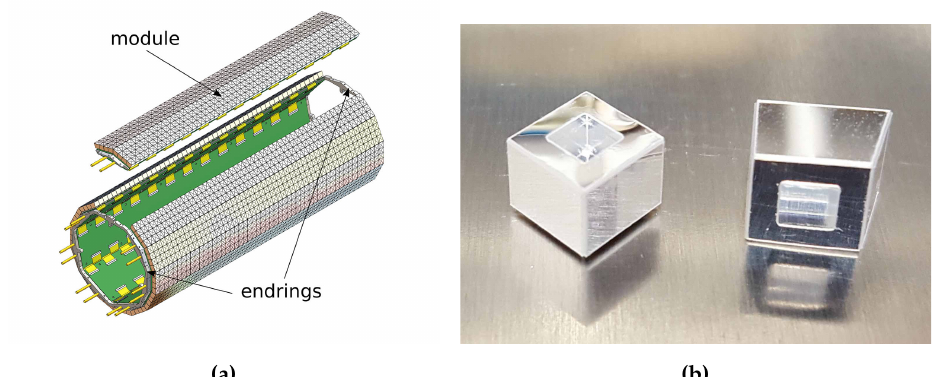
Figure 12. ( a ) Structure of one station of the tiles detector, with the individual tiles shown as small Figure 11.4: Individual tiles wrapped with ESR reflective squares. ( b ) Prototype of a scintillating tile wrapped with ESR foil foil. Figure 11.3: CAD rendered views of the tile detector.